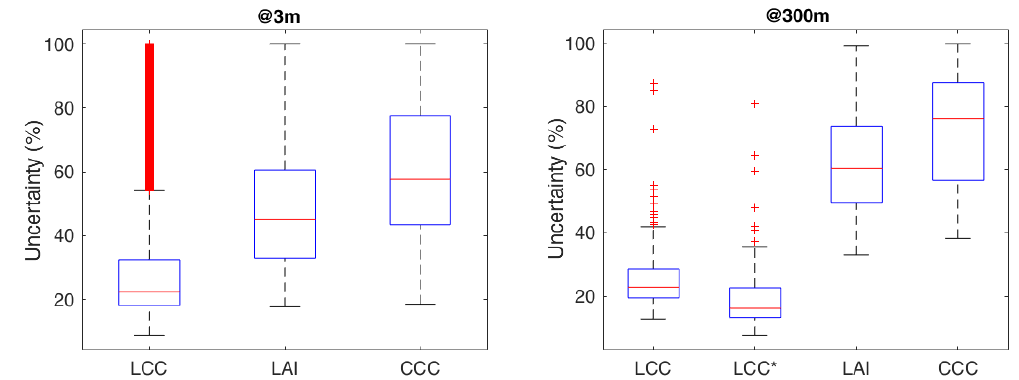
Figure 8. Comparison of the relative uncertainties, as defined by the coefficient of variances (%), at the spatial resolutions of 3 m ( left ) and 300 m ( right ). At the coarser resolution, the LCC model developed in [19] (LCC) and the newly developed model integrating pixel heterogeneity (LCC*) are compared. Data points beyond the whiskers are displayed with a red